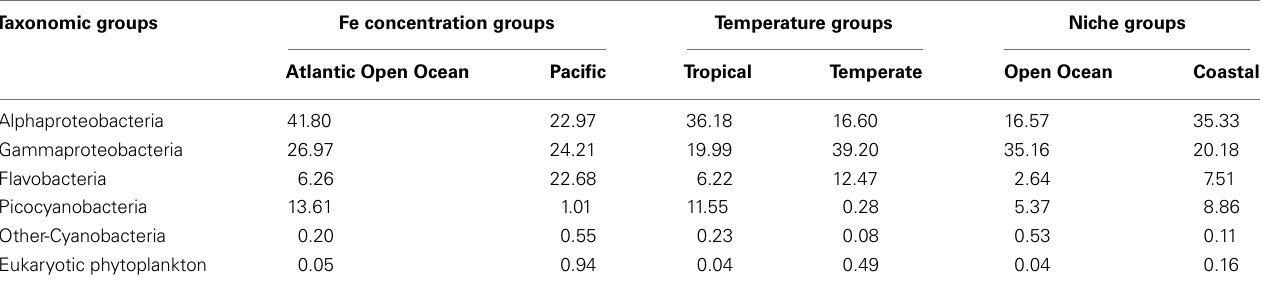
Table 5 |Taxonomic profiles of GOS metagenome niche